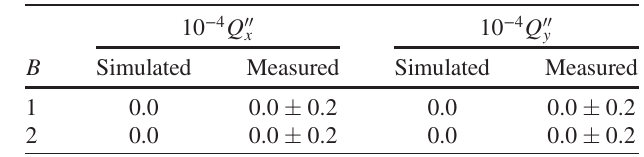
TABLE IV. MAD - X calculations vs measurements of second order chromaticity at 6.5 TeV for the two LHC beams ( B ) and at zero Landau octupole current for operational machine settings.